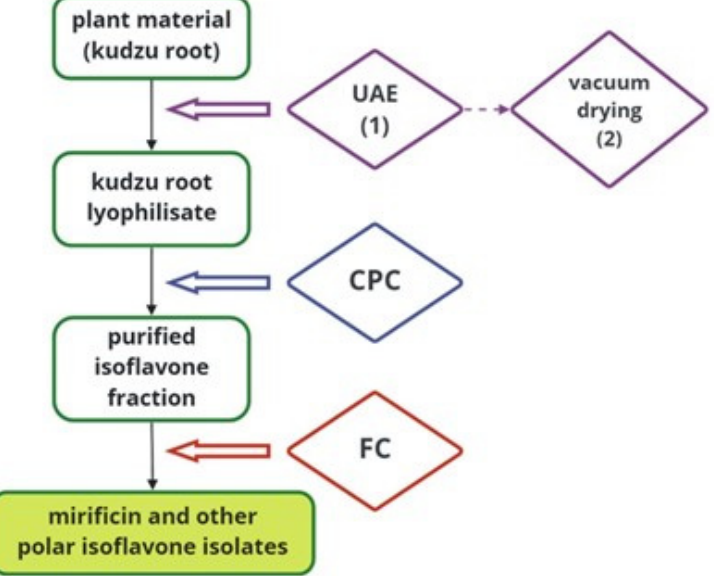
Figure 5. A block diagram illustrating the separation process of mirificin and related polar isoflavones using subsequent preparative techniques.